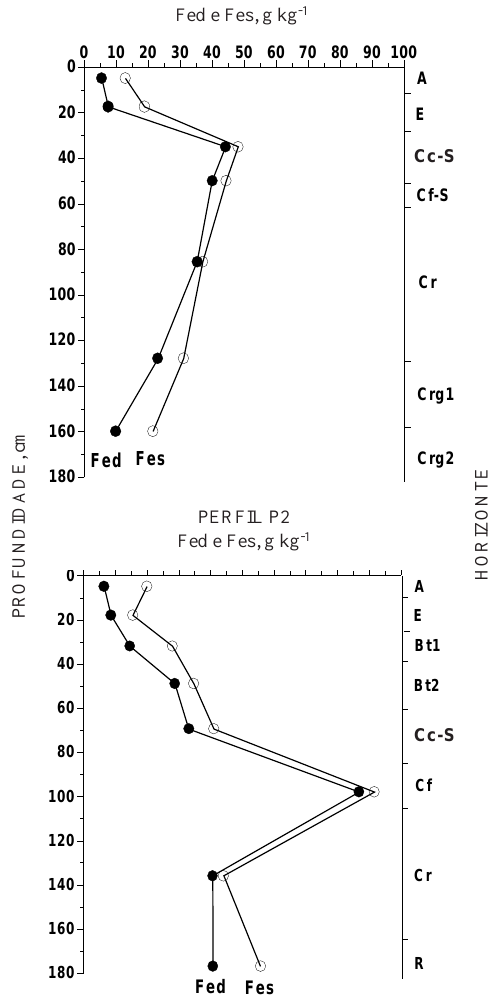
Figura 3. Distribuição, em profundidade, do ferro extraído com ataque sulfúrico (Fe ) e ditionito s de sódio (Fe ) para os perfis P1 e P2 (nos d horizontes nodulares considerou-se apenas sua matriz